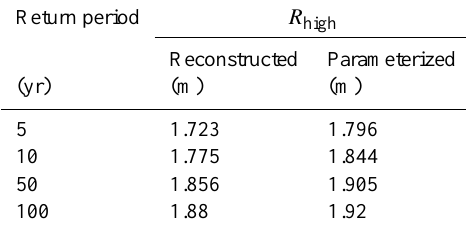
Table 5. Return values for R low corresponding to 5-, 10-, 50-, and 100-year return periods with the 95% confidence bounds values.